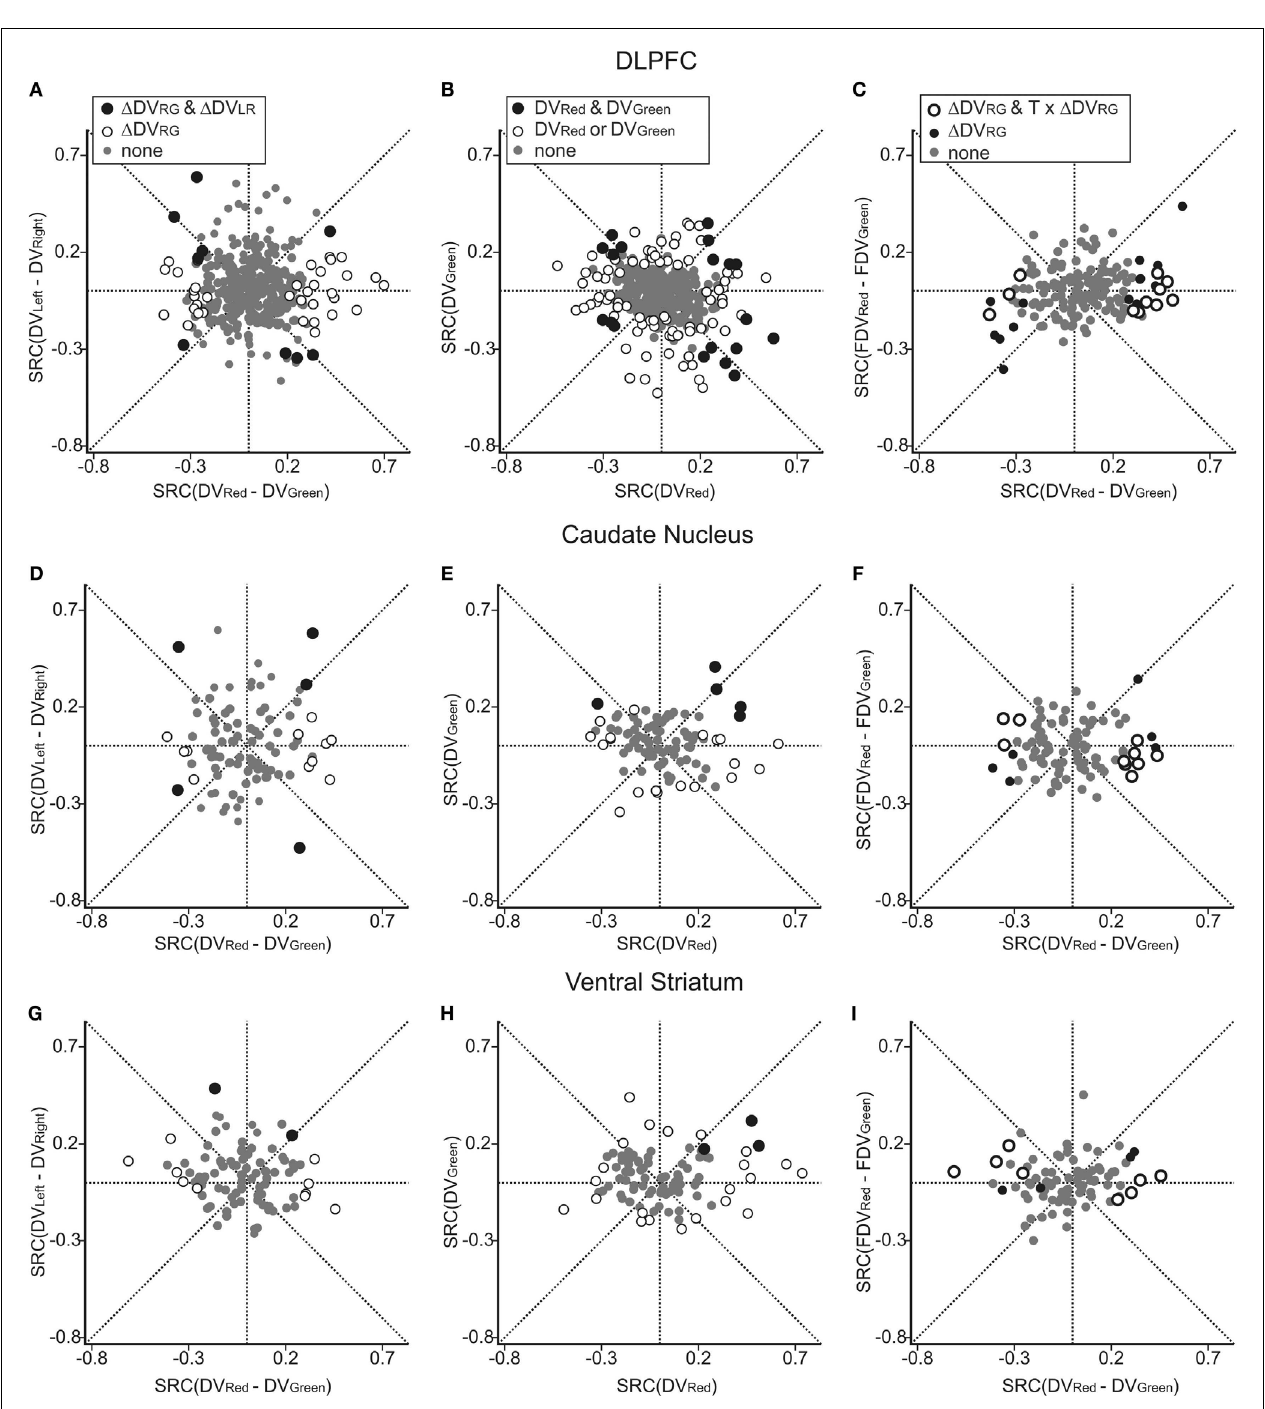
symbols, neurons showing significant effect of DVs for both red and green targets and for only one of the two targets, respectively. In (C,F,I) SRC for the difference in the DVs for red and green targets during choice trials (ordinate) are plotted against the SRC for the difference in the fictitious DVs for red and green targets during control trials (FDV Red − FDV Green ). Empty circles, neurons showing significant effect of ∆ DV RG and significant interaction between RG and the task (model 4); black filled symbols, neurons showing significant effect of ∆ DV RG without significant interaction with